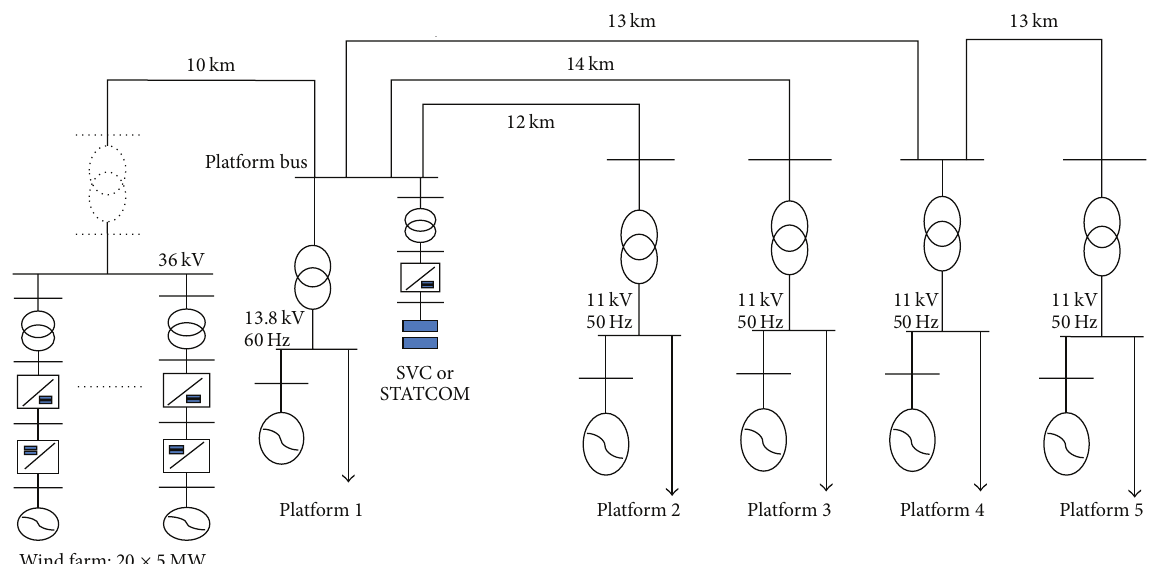
Figure 3: Simplified single-line diagram of the five platforms’ grid.